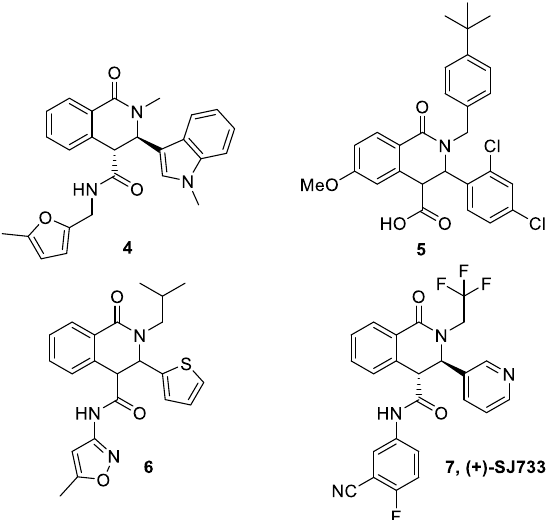
Figure 2. Examples of diversely biologically active tetrahydroisoquinolones.